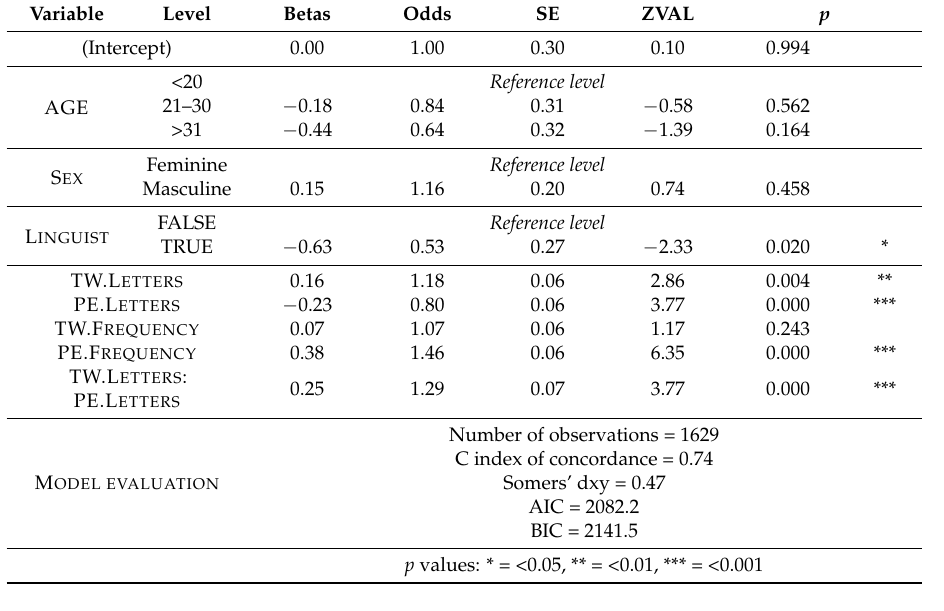
Table A3. Full results from the logistic regression model.